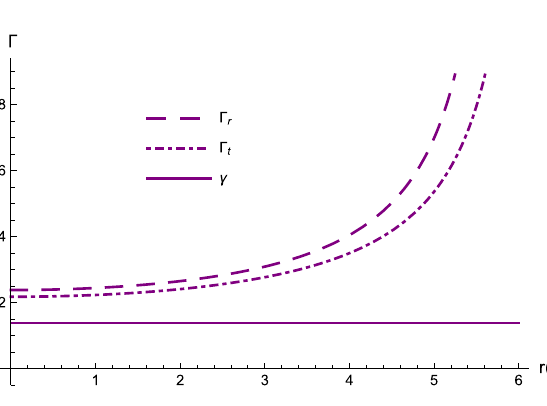
Fig. 10 Adiabatic Index for SAX J1808.4-3658